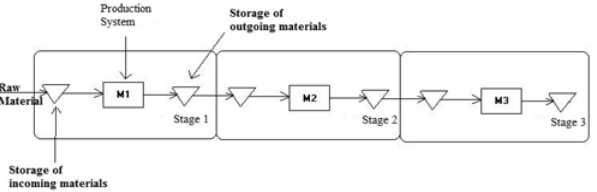
Figure 1 . Serial production system divided into